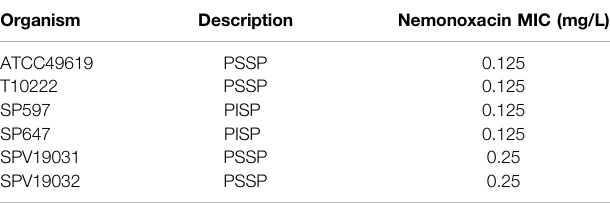
TABLE 1 | In vitro activity of nemonoxacin against study